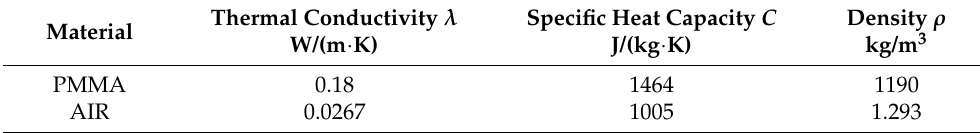
Figure 6. The dimension diagram of the specimen. Table 1. The thermal parameters of PMMA and AIR.